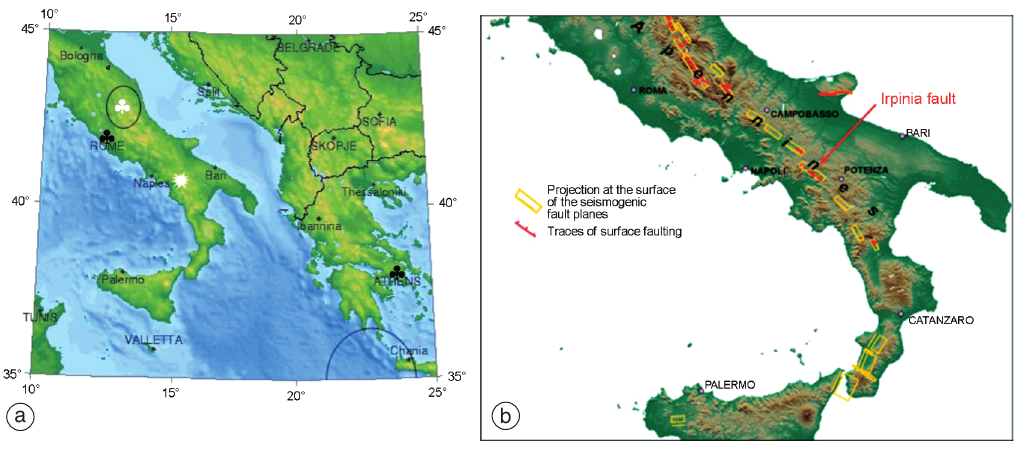
Fig. 1a,b. a) The map of Central Mediterranean. Black ♣ indicate positions of ionosondes at Rome and Athens, white ♣ indicates the Rieti radon monitoring station. Star indicates the position of Irpinia earthquake epicenter. Ovals indicate the position of ionospheric anomalies registered by Intercosmos-19 satellite. b) Configuration of active tectonic faults at Apennines